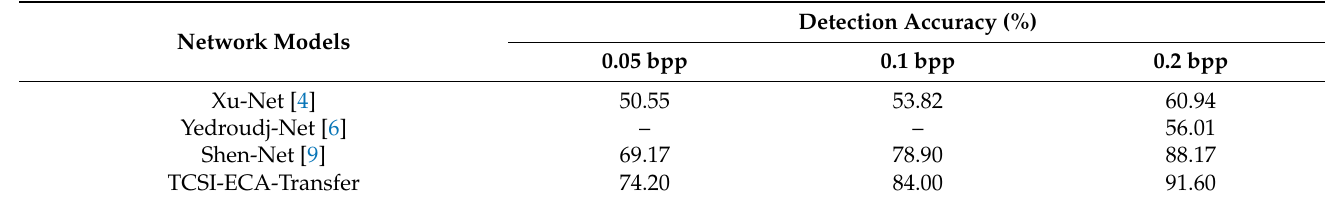
Table 4. Accuracy comparison with other models when using the S-UNIWARD algorithm.